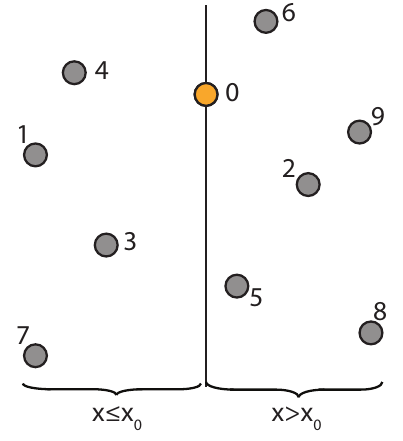
Figure 4. Visualization of splitting the data set from Figure 3 into two groups.